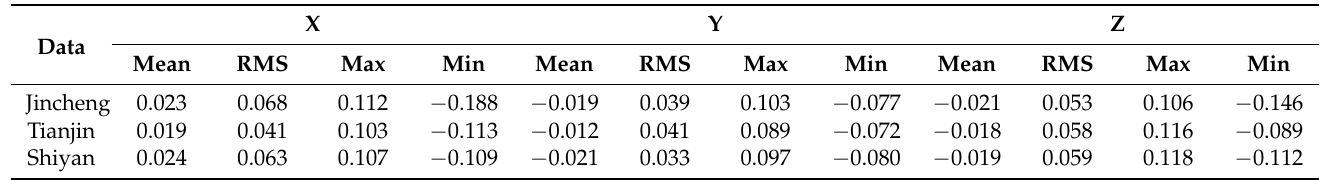
Table 8. Ground coordinates differences statistics based on calibrated alignment angles and pointing angle files. (Unit: meter).